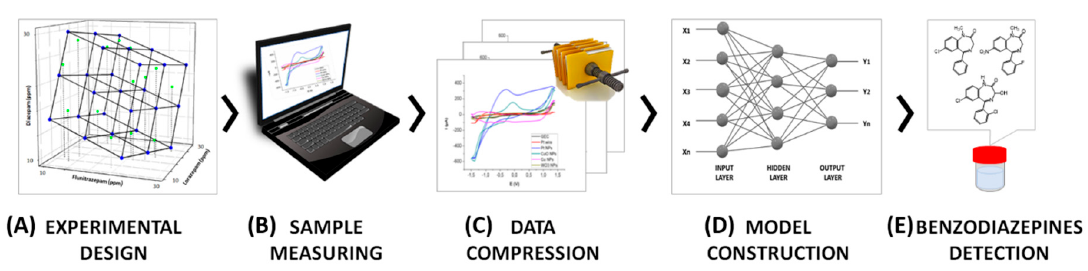
Figure 2. Scheme depicting the main steps of the ET approach used in the simultaneous determination of BZs.